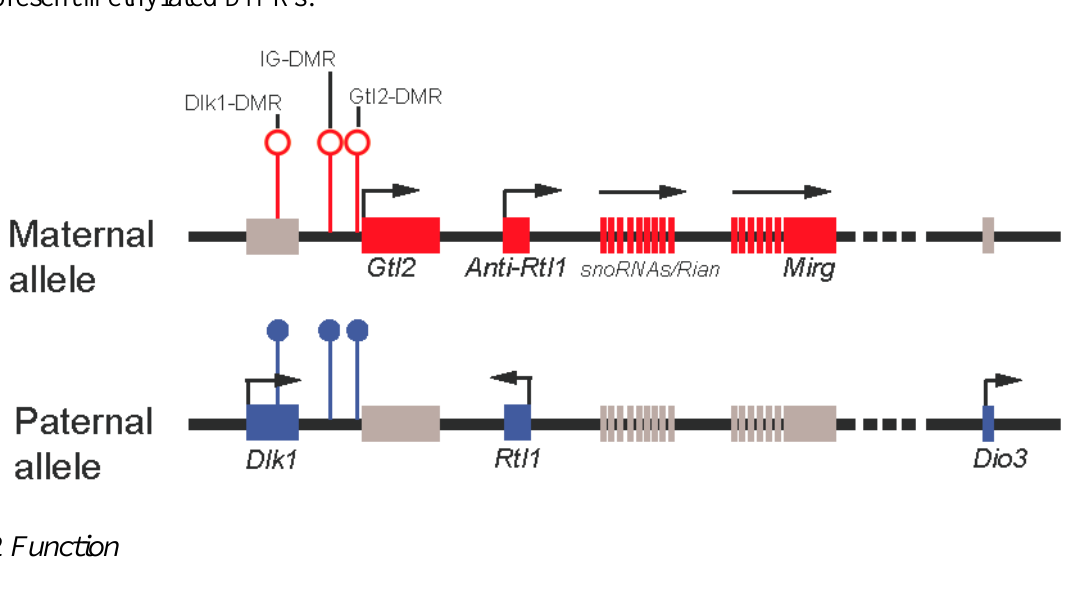
Figure 2. Schematic representation of the mouse imprinted locus Dlk1-Dio3 . Red rectangles represent maternally-expressed genes, and blue represent paternally-expressed genes. Gray rectangles represent repressed genes. Open circles represent unmethylated DMRs, and filled represent methylated